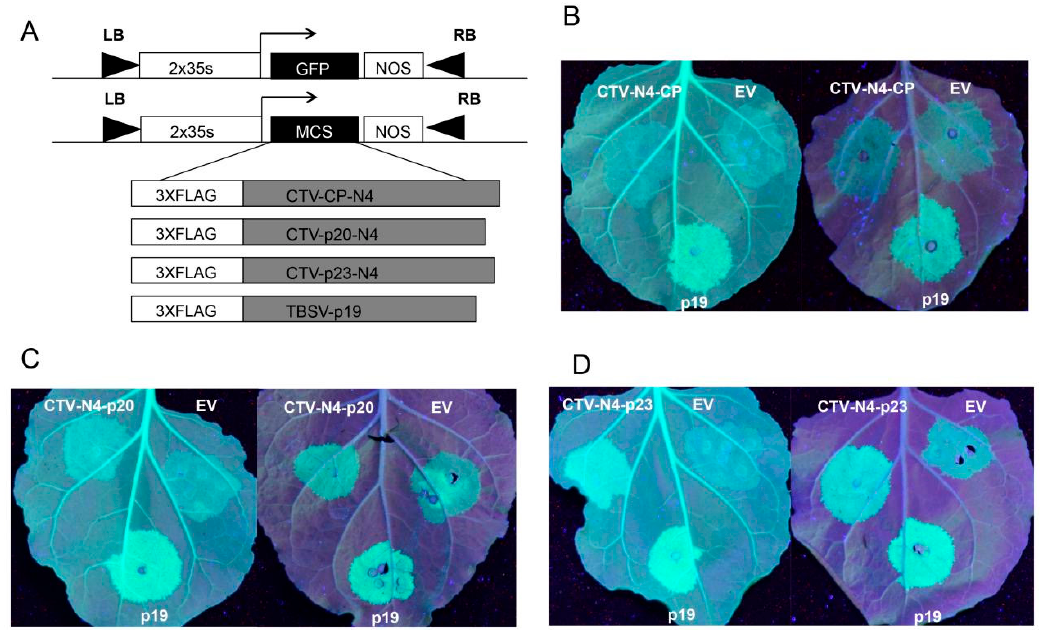
Figure 2. Silencing suppressor function of CTV-N4 proteins (CP) p20 and p23. ( A ) Schematic representation of expression cassettes for 35S-GFP, N4CP, N4p20, N4p23, and p19. The 2x 35S promoter, terminator (NOS), and N-terminal 3xFLAG tags are shown as open boxes. Filled triangles represent T-DNA left (LB) and right (RB) border. For B, C and D, the 16c leaf is on the left and the Nicotiana benthamiana wild type leaf is on the right. ( B ) Representative picture of leaves co-expressing 35S-GFP with N4CP, negative control empty vector (EV), and positive control p19, respectively. ( C and D ) N4p20 and N4p23 expressing leaves as in B.